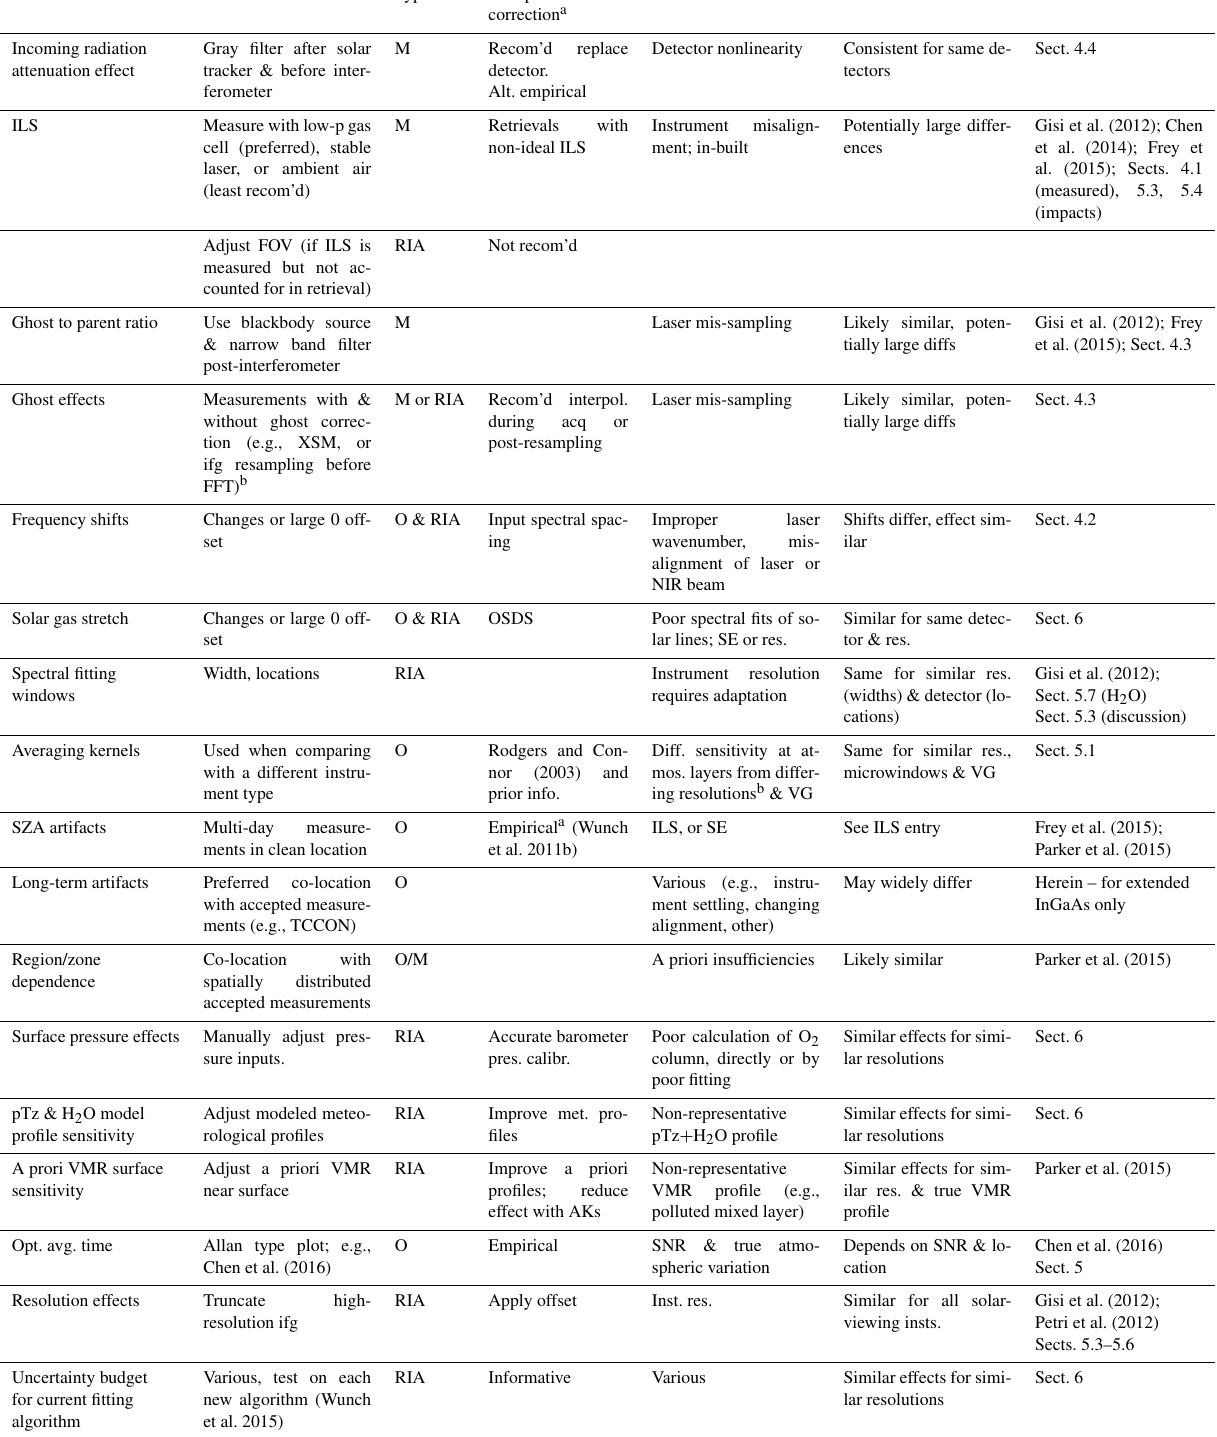
Table 6. Tests for assessing biases and sensitivities of solar-viewing, remote sensing